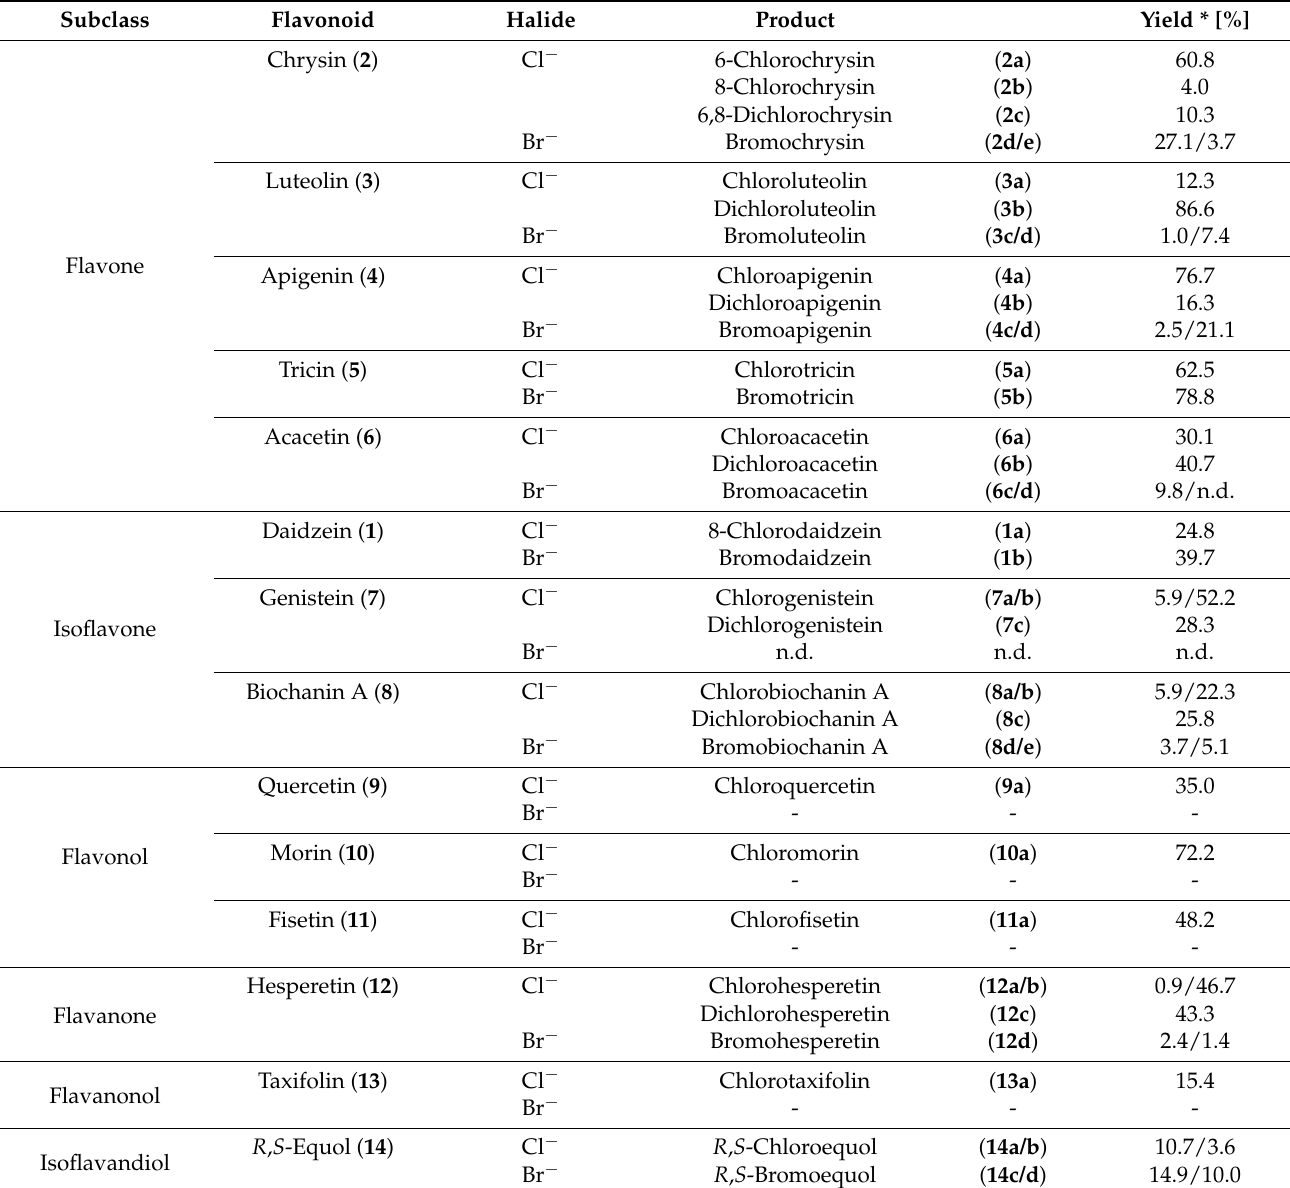
Table 1. Halogenation products observed by feeding experiments listed according to flavonoid subclass.